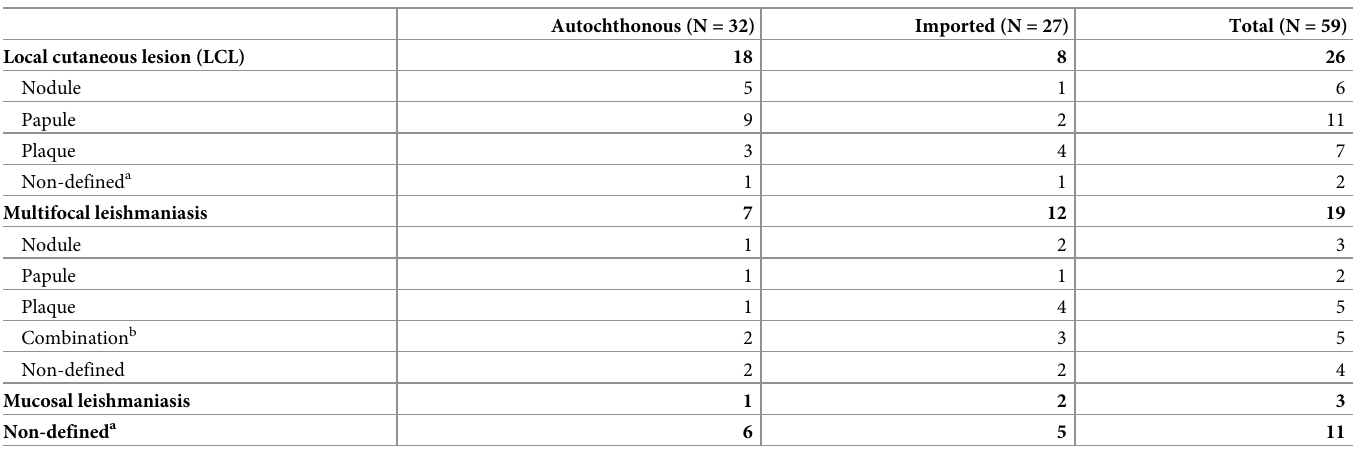
96 (38.5%) swab samples. In 13 patients, both swab and biopsy samples were performed simul- taneously, obtaining concordant results; seven (53.8%) of these patients had a positive real- time PCR result. The laryngeal biopsy also tested positive for Leishmania DNA. Retrospectively, in 39 skin biopsies immunohistochemistry and real-time PCR have been performed in parallel. A total of 17 of 39 (43.6%) samples were positive with both techniques, 18 of 39 (46.1%) samples were negative by both techniques, and 4 of 39 (10.3%) samples were negative by immunohistochemistry but positive by real-time PCR. Species identification could not be performed in 8 of 59 (13.6%) cases and in 11 of 59 (18.6%) patients it was not performed because they were autochthonous cases with typical lesion. Molecular characterization of Leishmania species was determined in 40 of 59 (67.8%) confirmed patients. L . (L . ) infantum and L . (L . ) major were found to be the most frequent spe- cies in 50% (20/40) and 45% (18/40) of cases, respectively. Almost all the samples typed as L . (L . ) major (17 of 18; 94.4%) were from patients in Morocco, except one sample from a patient who traveled to Israel (1 of 18; 5.6%). The vast majority of samples typed as L . (L . ) infantum (17 of 20; 85%) were from autochthonous cases and the remaining three (3 of 20; 15%) were Table 1. Different clinical presentation of CL per the source of infection. Autochthonous (N = 32) Imported (N = 27) Total (N = 59) Local cutaneous lesion